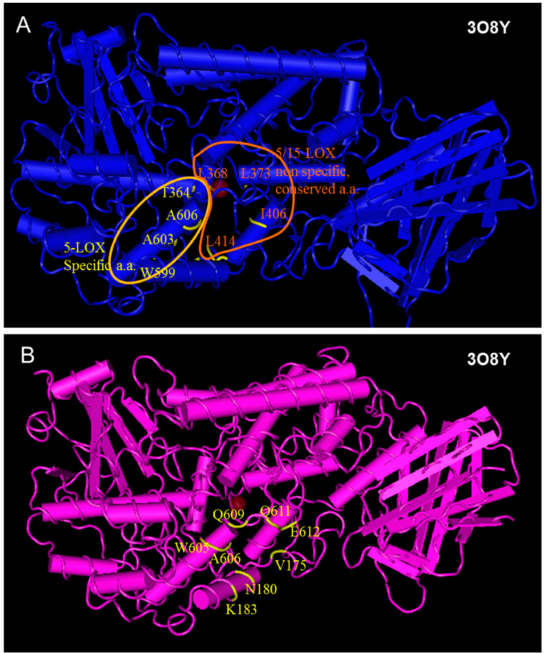
Figure 11. ( A ) Conserved and 5-LOX specific amino-acids which participate in interactions with substrates and inhibitors at the active site of 3O8Y, indicated in yellow (some of them barely seen because they are hidden inside the cavity); ( B ) Amino acids interacting with compound 11 in the preferred docking pose to 308Y (center x: − 12.5 Å, y: 75.5 Å, z: 0.5 Å, box 35 × 25 × 27). The interacting amino acids are located at the external area of the